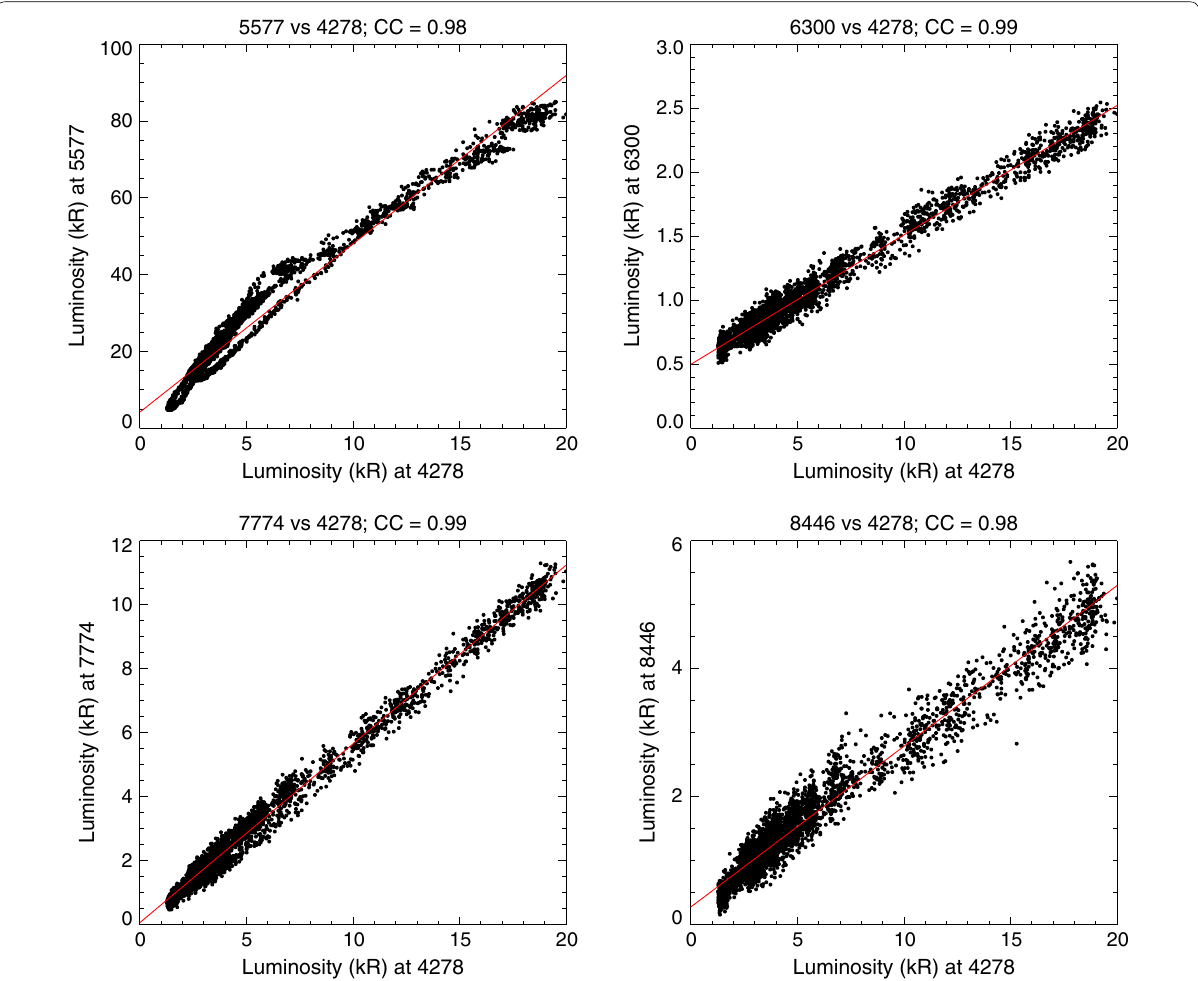
Fig. 15 Scatter plots of auroral intensities (20 Hz data) between 427.8 nm and 557.7 nm (top-left), 630 nm (top-right), 777.4 nm (bottom-left), and 844.6 nm (bottom-right) obtained for 2 min between 19:43:00 UT and 19:45:00 UT on January 22, 2018. Correlation coefficients (CC) are also shown at each panel. Red solid lines are fitted lines determined with the least square